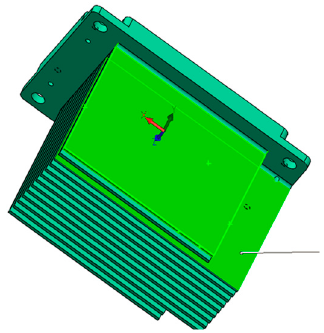
Figure 5. Heat sink design. Table 3. Performance estimate for heat sink and fan.